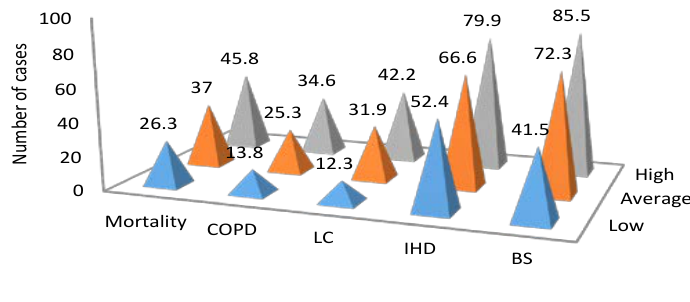
to mortality and diseases 2.5